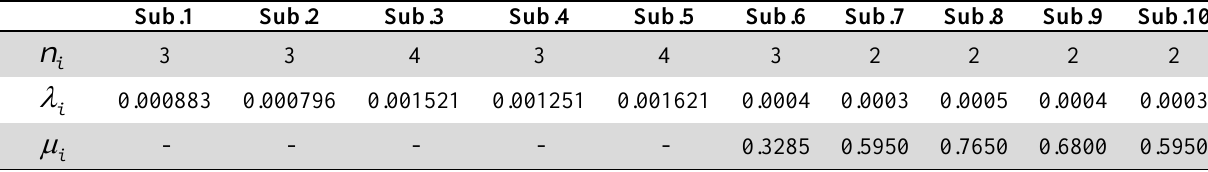
Details of solution number 1with cost=1000